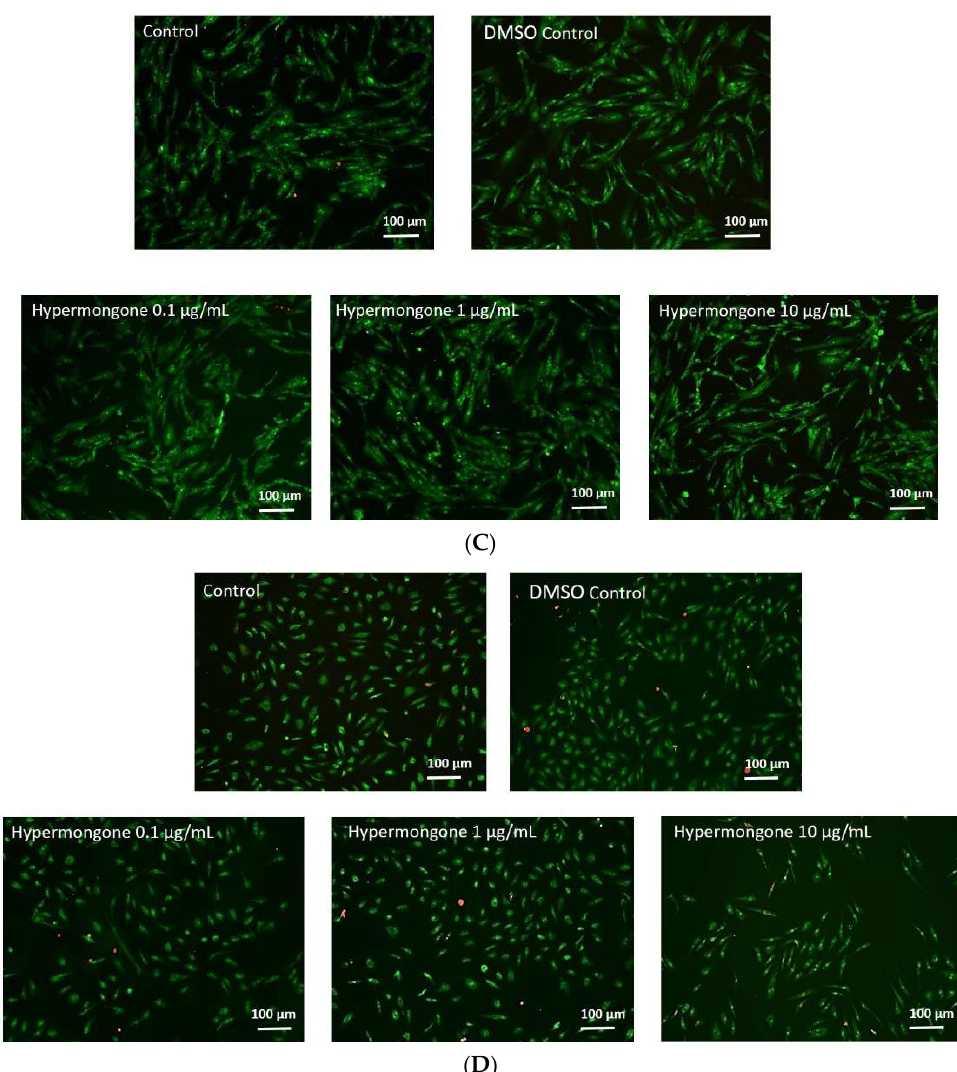
Figure 2. Concentration-dependent cell proliferation of ( A ) human dermal fibroblasts (HDFs) in response to various concentrations of hypermongone C after 24-h exposure, calculated using the MTS assay. No toxicity was observed in the range of 0.1 and 1 µg/mL when compared to the control (untreated cells in growth media). ( B ) The percentage viability of human umbilical vein endothelial cells (HUVECs) in response to 8-h incubation with various concentrations of hypermongone C did not show toxicity by the MTS assay. ( C ) The LIVE/DEAD ® assay of HDFs and ( D ) HUVECs confirmed the non-toxic effect of hypermongone C on the cells.